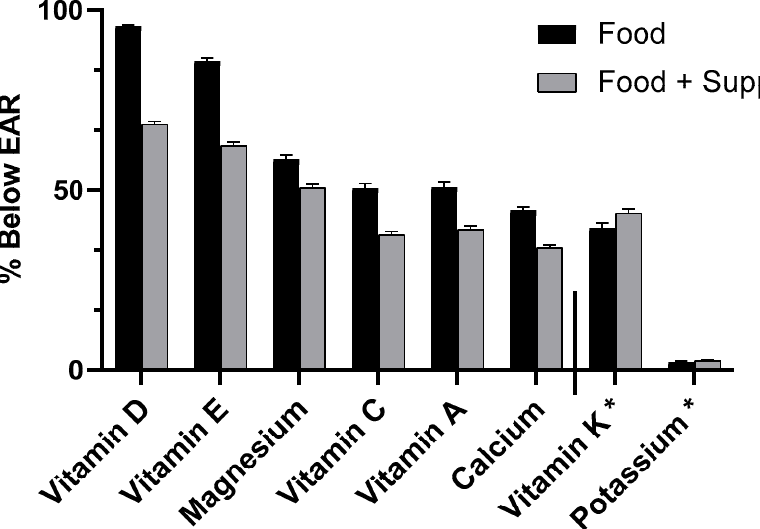
Figure 1. Prevalence of inadequacy (% of population below EAR) from Food Only and Food + Spp, all adults aged 19 + years with short sleep duration ( < 7 h). *% above adequate intake